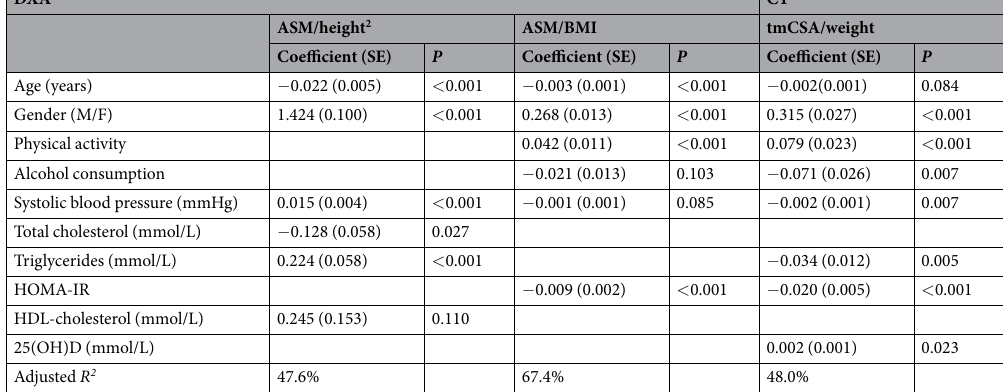
Table 2. Multiple linear regression analysis to identify clinical and metabolic variables associated with ASM/ height 2 , ASM/BMI, or tmCSA/weight. The following covariates were considered independent variables prior to stepwise variable selection approach: age, gender, alcohol consumption, smoking status, physical activity, systolic blood pressure, total cholesterol, triglycerides, HDL-cholesterol, HOMA-IR, hsCRP, 25(OH)D values.